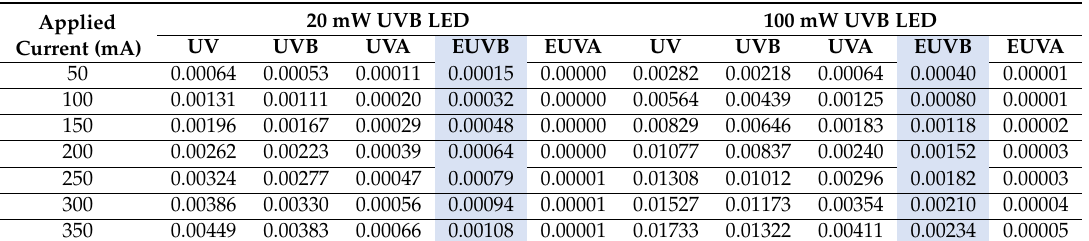
Table 4. Irradiance of the UVB LED light source modules by applied current. (distance: 150 cm) (unit: W/m 2 ).